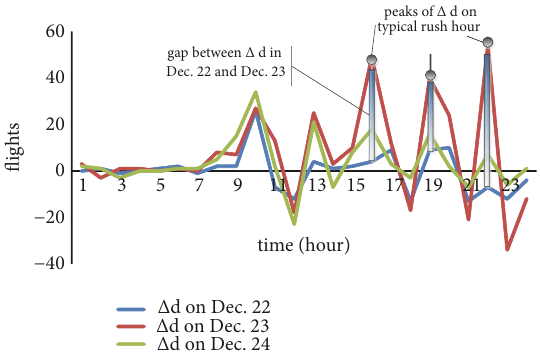
Figure 8: Schedule flights on typical congestion days.